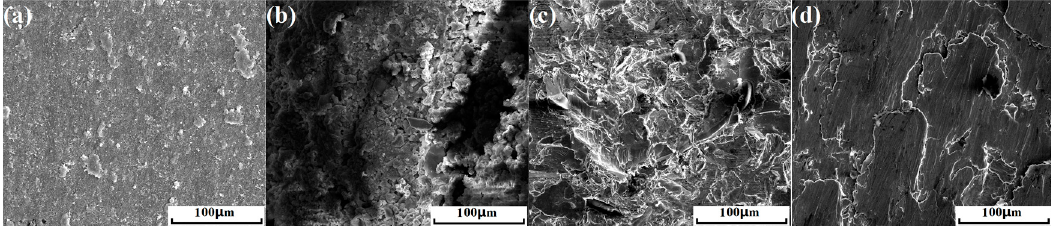
Figure 11. SEM top-view surface microstructures of different rebars: ( a ) as-received, ( b ) rusted, ( c ) sand-blasted, and ( d ) wire-brushed.